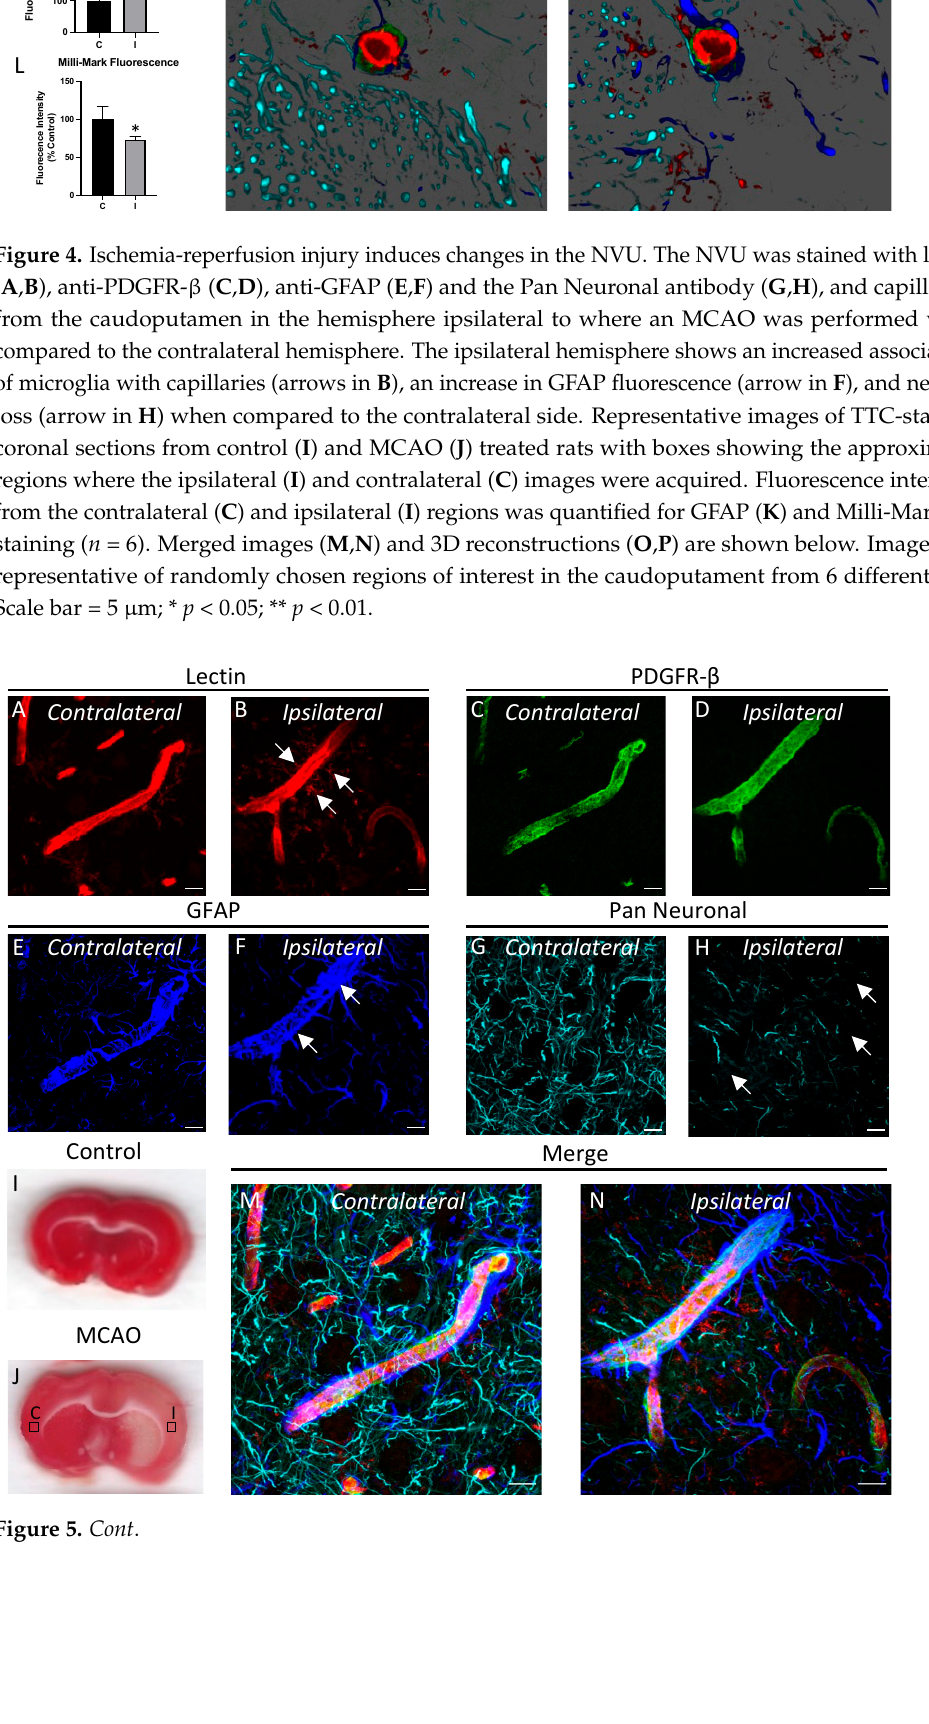
Figure 5. Ischemia-reperfusion injury induces changes in the NVU. The NVU was stained with lec- tin ( A , B ), anti-PDGFR- β ( C , D ), anti-GFAP ( E , F ) and the Pan Neuronal antibody ( G , H ), and cortical microvessels in the hemisphere ipsilateral to where an MCAO was performed were compared to the contralateral hemisphere. The ipsilateral hemisphere shows an increased association of micro- glia with capillaries (arrows in B ), an increased in GFAP fluorescence (arrows in F ), and neurite loss (arrows in H ) when compared to the contralateral side. Representative images of TTC-stained cor- onal sections from control ( I ) and MCAO treated rats ( J ) with boxes showing the approximate re- gions where the ipsilateral ( I ) and contralateral ( C ) images were acquired. Fluorescence intensity from the contralateral ( C ) and ipsilateral ( I ) regions was quantified for GFAP ( K ) and Milli-Mark ( L ) staining ( n = 6). Merged images ( M , N ) and 3D reconstructions ( O , P ) are shown below. Images are representative of randomly chosen regions of interest in the somatosensory cortex from 6 differ- ent rats. Scale bar = 10 μ m; * p < 0.05. 4. Discussion It is important that the NVU properly functions so cerebral blood flow can be pre- cisely regulated, the BBB can be established and maintained, and extracellular fluid can